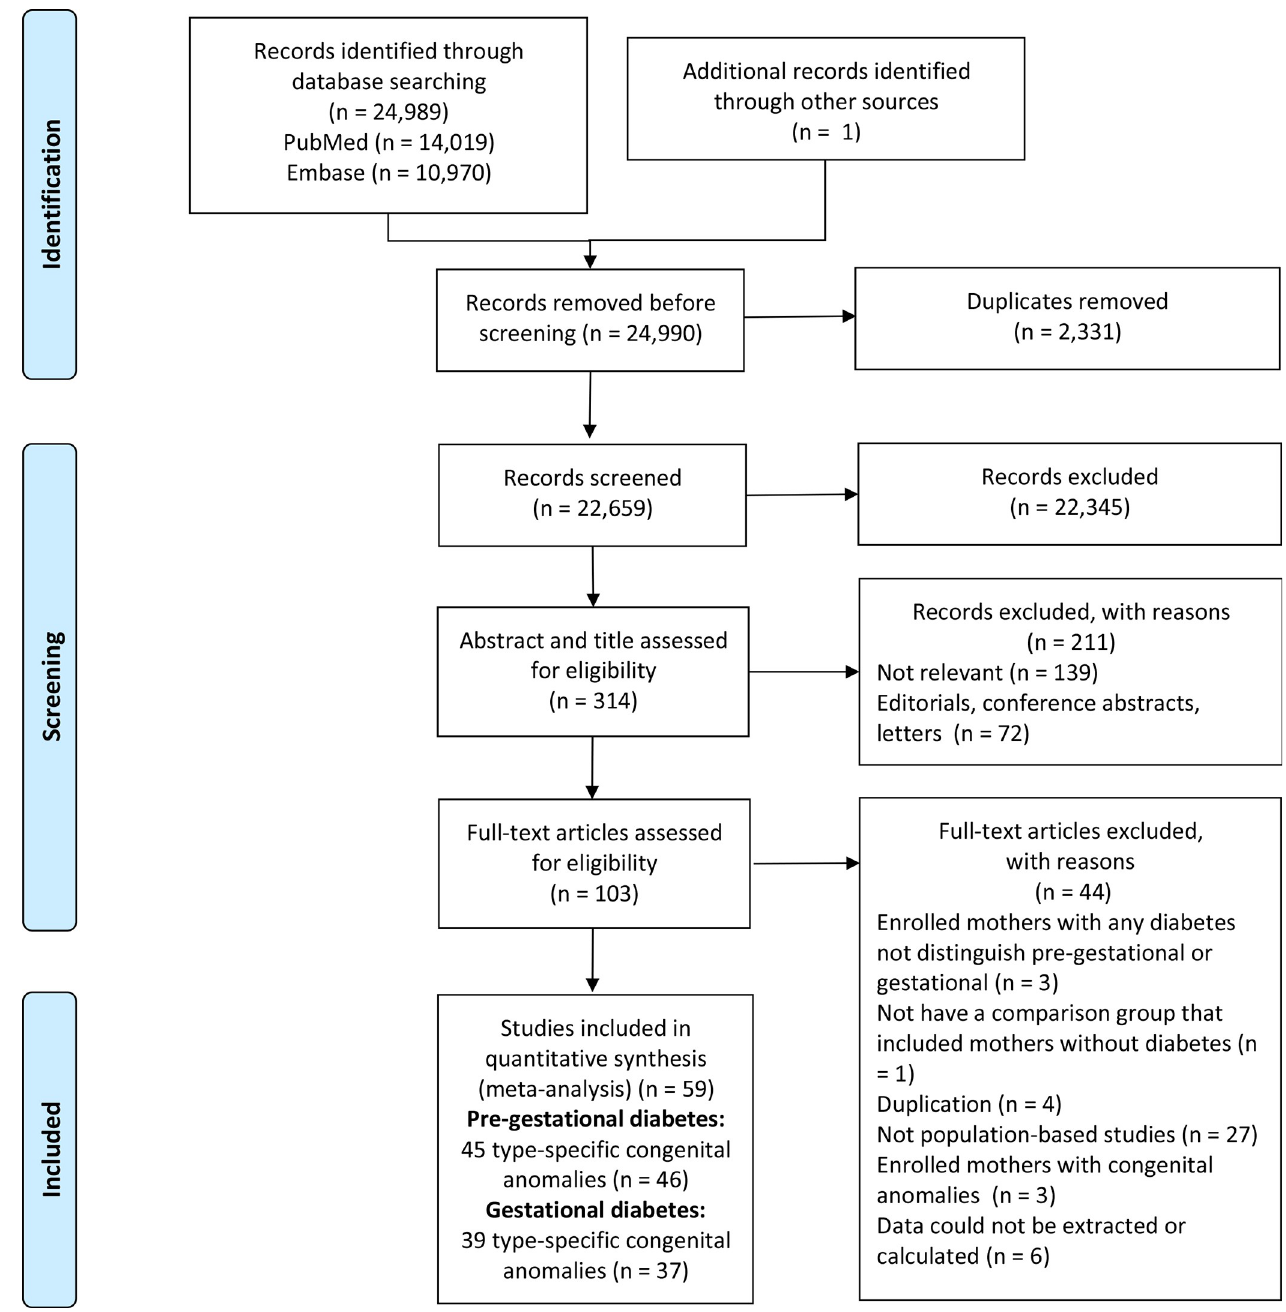
Fig 1. Flowchart of selection of studies included in the